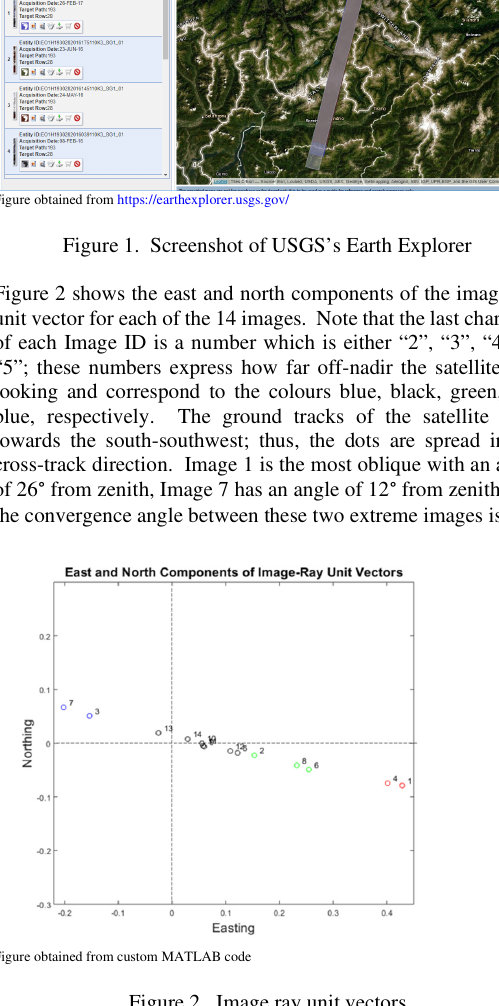
Figure 2. Image ray unit vectors